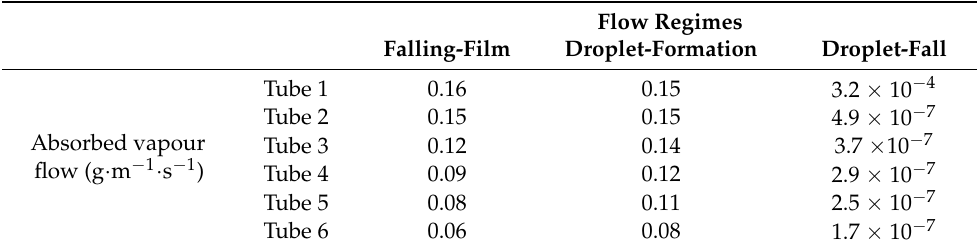
Table 4. Vapour absorption rate in each flow regime and tube.